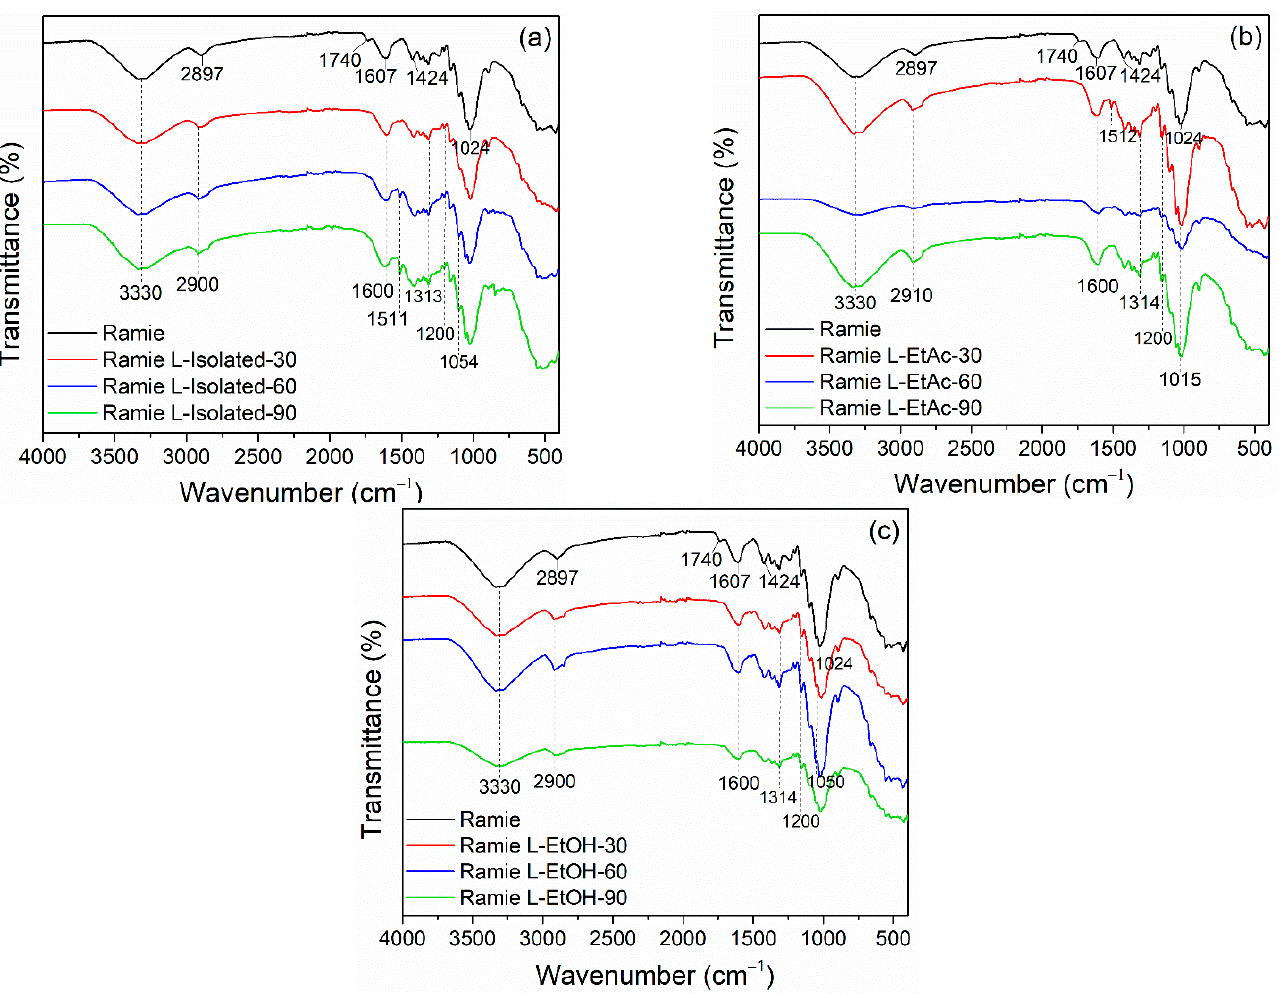
Figure 6. FTIR spectra of ramie fiber impregnated with lignin-based bio-PU at different times: ( a ) ramie impregnated with L-isolated, ( b ) ramie impregnated with L-EtAc, ( c ) ramie impregnated with L-EtOH.